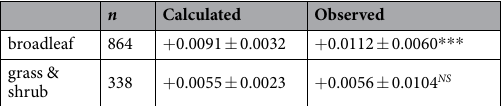
Table 4. Calculated and observed slopes of spatial regressions of log 10 R SF (ratio of SOC concentration in second to first soil sampling) against N dep (gNm − 2 a − 1 ) in 2000 at 5 km grid resolution across Great Britain. The number of sites is indicated by n , error values are 95% confidence intervals. Whether the observed slope is significantly different from zero is shown by NS (not significant) and *** (P ≤